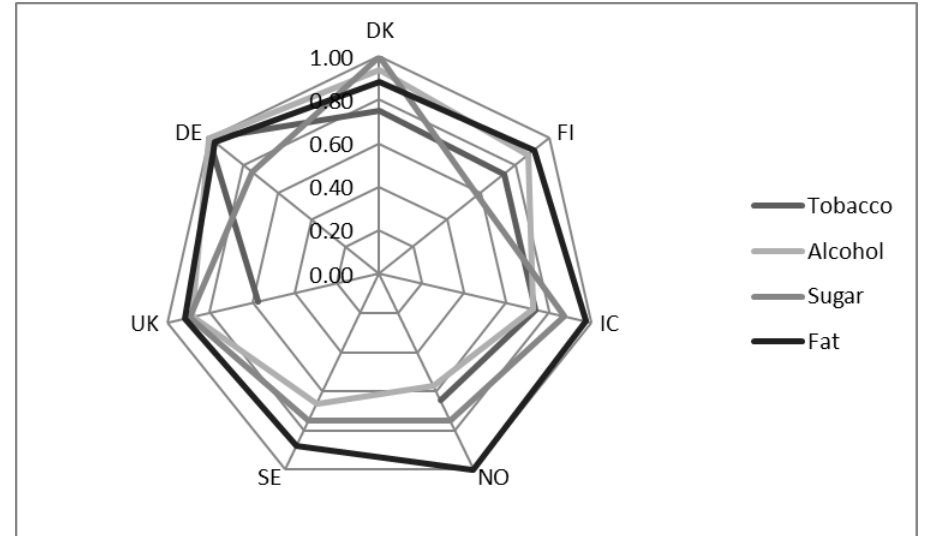
Figure 8: Relative distribution of non-medical determinants of health by country, 2011